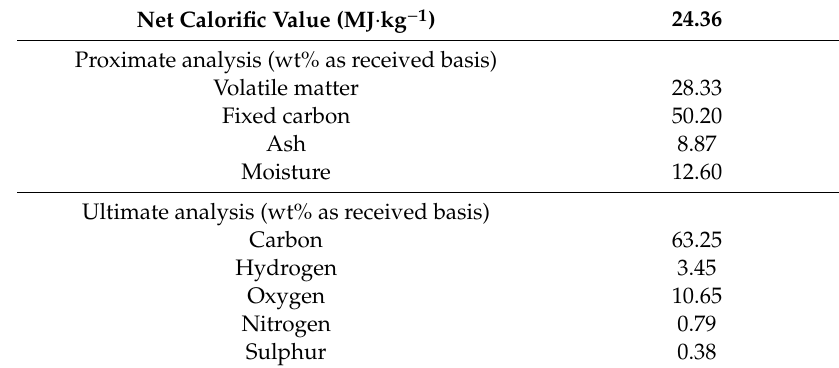
Table 1. Proximate and ultimate analyses of coal sample (wt%, as-received basis (ar)).